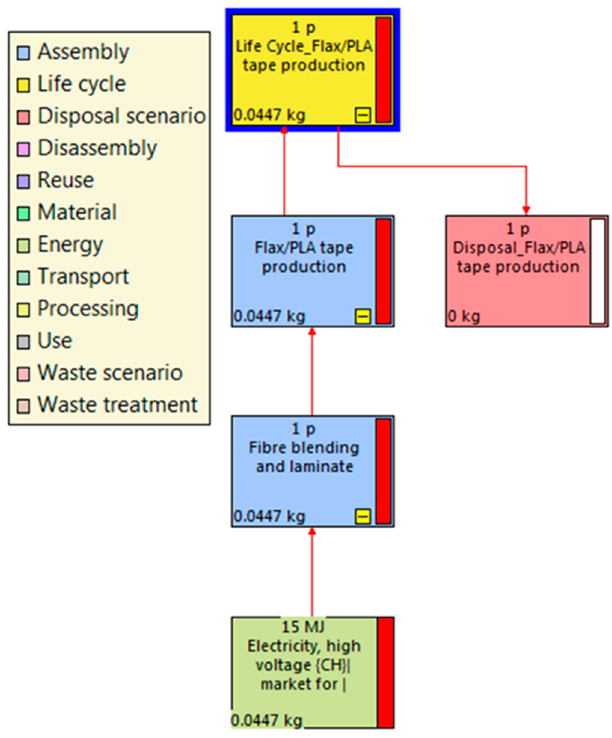
Figure 6. SimaPro 8 LCA simulation for the production of Flax / PLA